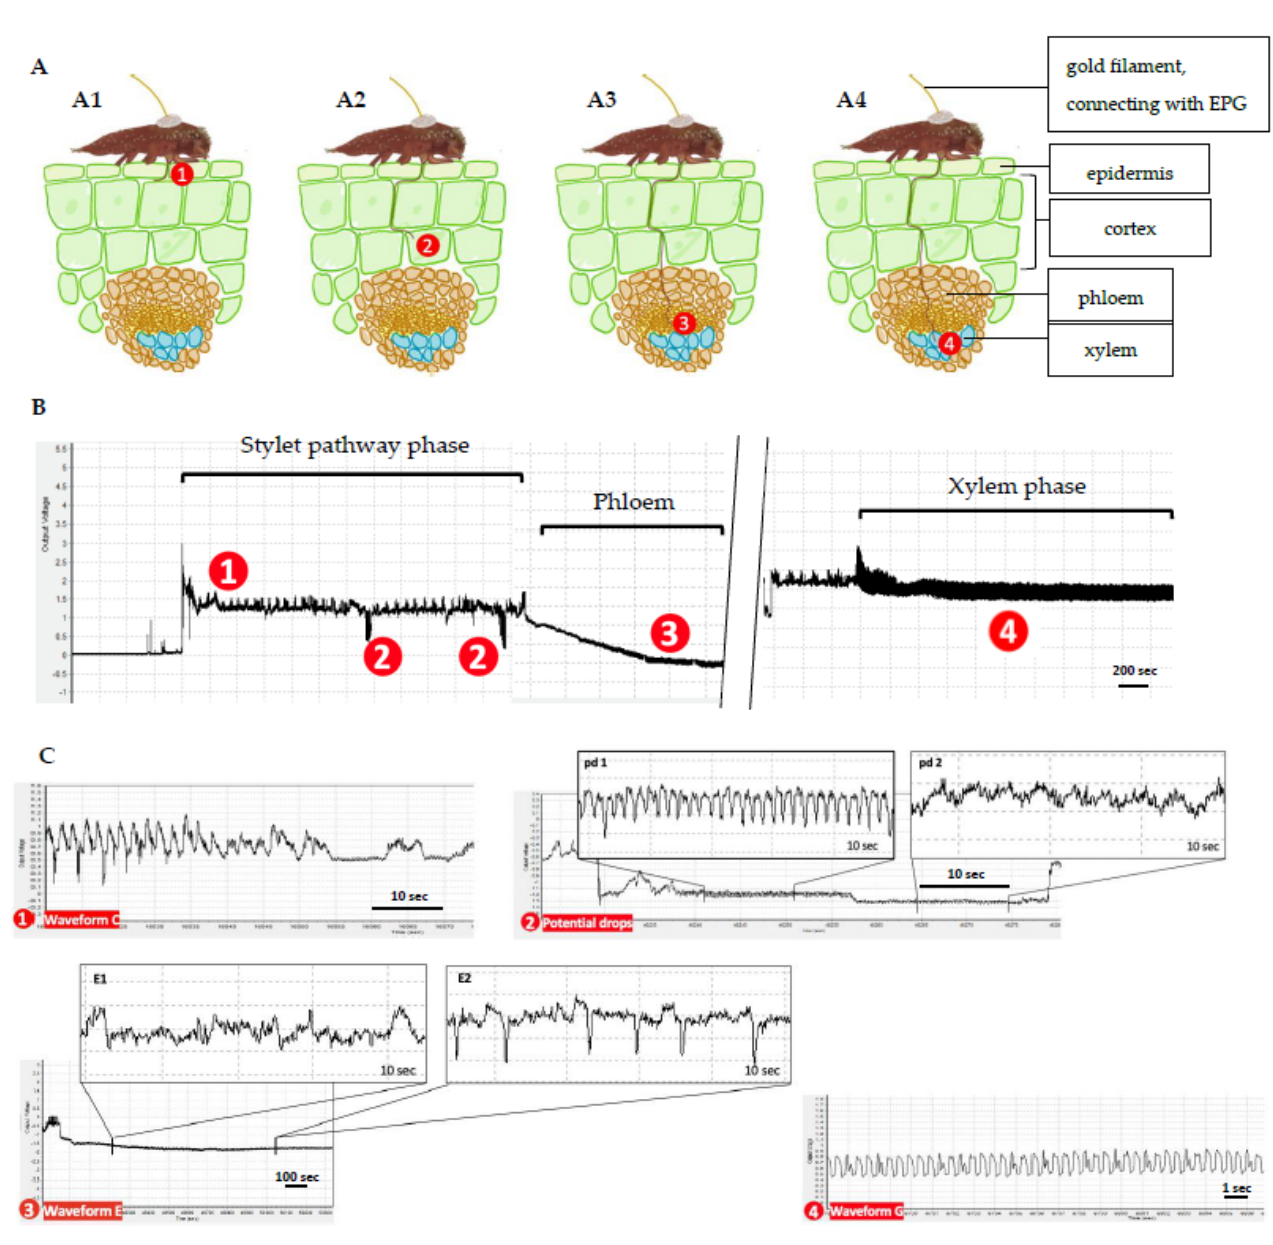
Figure 1. General scheme of typical EPG waveforms associated with specific probing activities of Acanthococcus lagerstroemiae on Lagerstroemia limii . ( A ) diagram shows different positions of A. lager- stroemiae stylet tips poking in plant tissue which were labelled as 1, 2, 3, and 4, respectively. ( B ) The general scheme shows specific EPG waveforms associated with the #1, #2, #3, and #4 positions of the stylet tip in the plant tissue, respectively. ( C ) ① Waveform C was detected when A. lagerstroe-